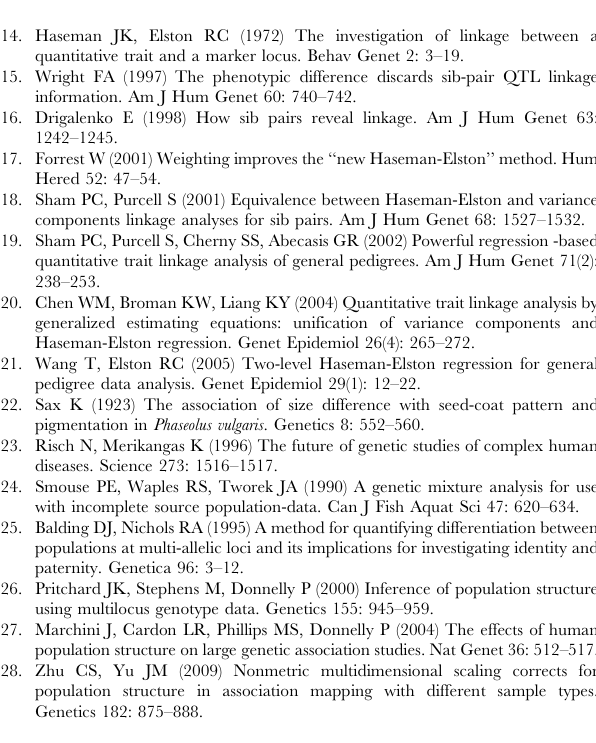
Table S3 Effect of sample size on multi-QTL mapping in the second simulation experiment (200 replicates).